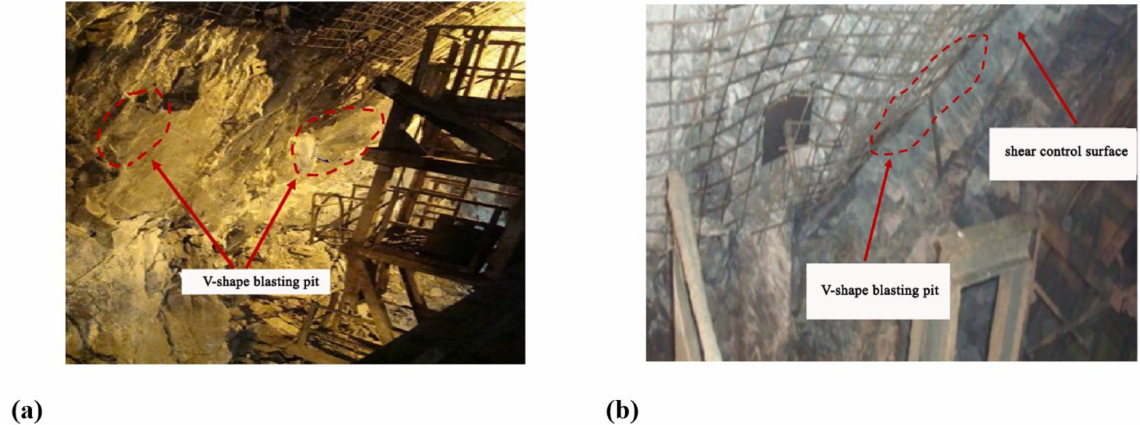
Figure 5. V-shaped blasting pit at the rockburst site: ( a ) V-shape blasting pit without supporting structure; ( b ) V-shape blasting pit with supporting